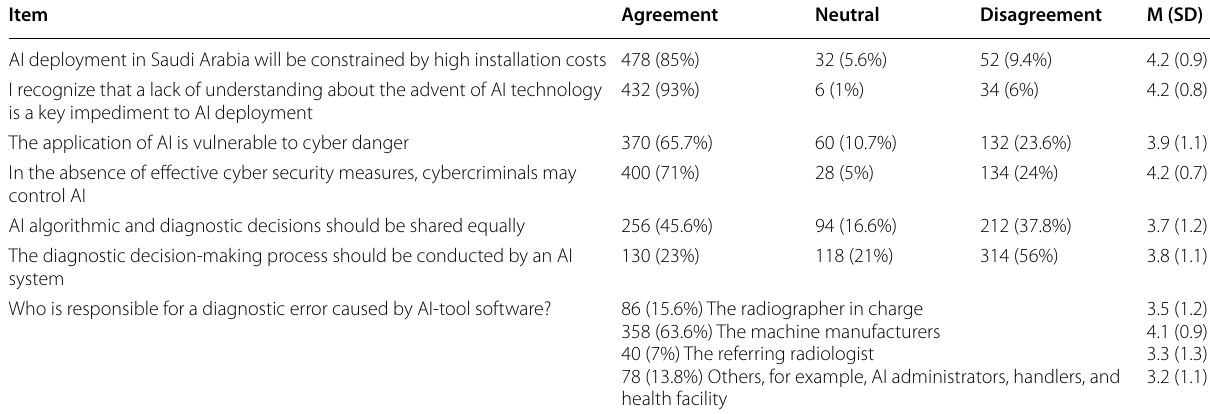
Table 5 Perspectives on the determinants that affect AI deployment and decision-making in medical